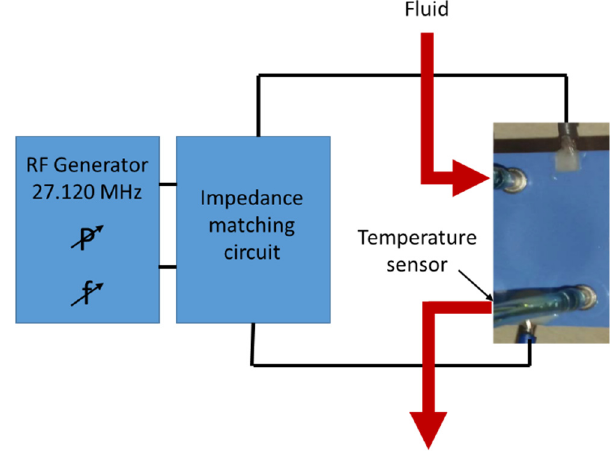
Figure 4. Schematic presentation of the testing setup.